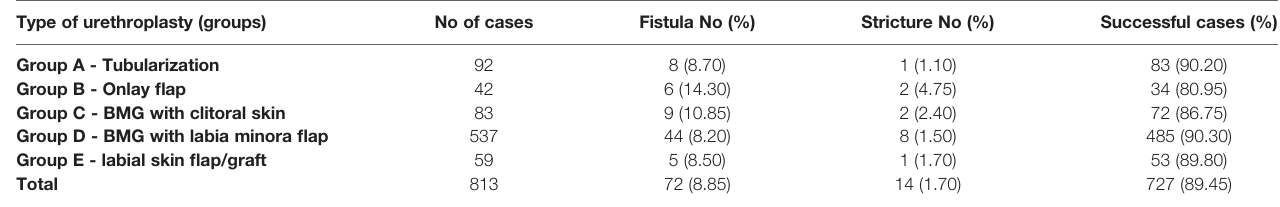
TABLE 2 | Urethral lengthening: outcomes and